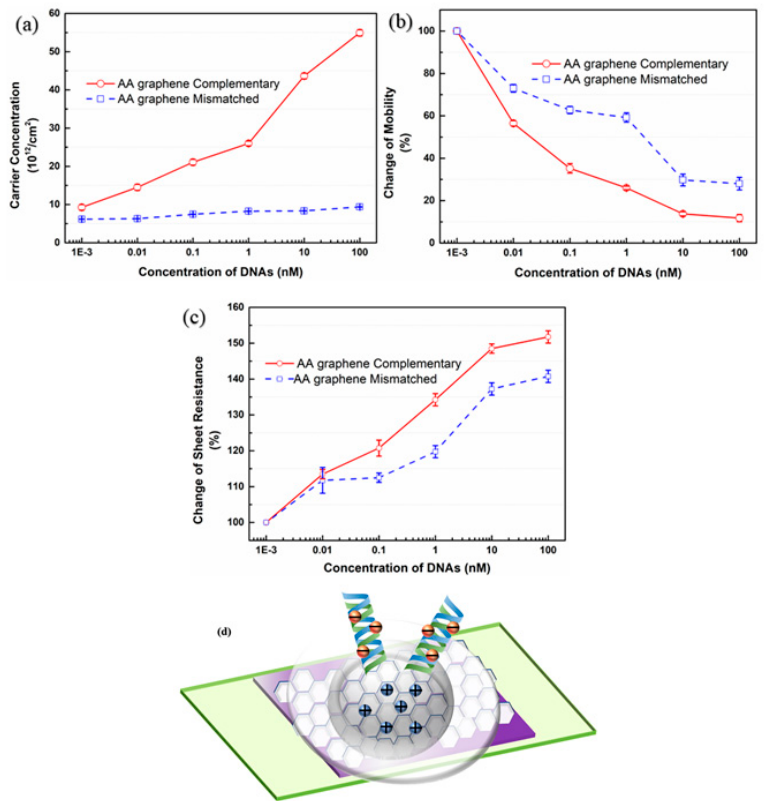
Figure 10. The variation of ( a ) carrier concentration; ( b ) carrier mobility and ( c ) sheet resistance of graphene-based Hall effect devices as a function of added concentrations of target and one-base mismatched DNA, respectively, based on AA graphene; ( d ) structure of electric double layer.